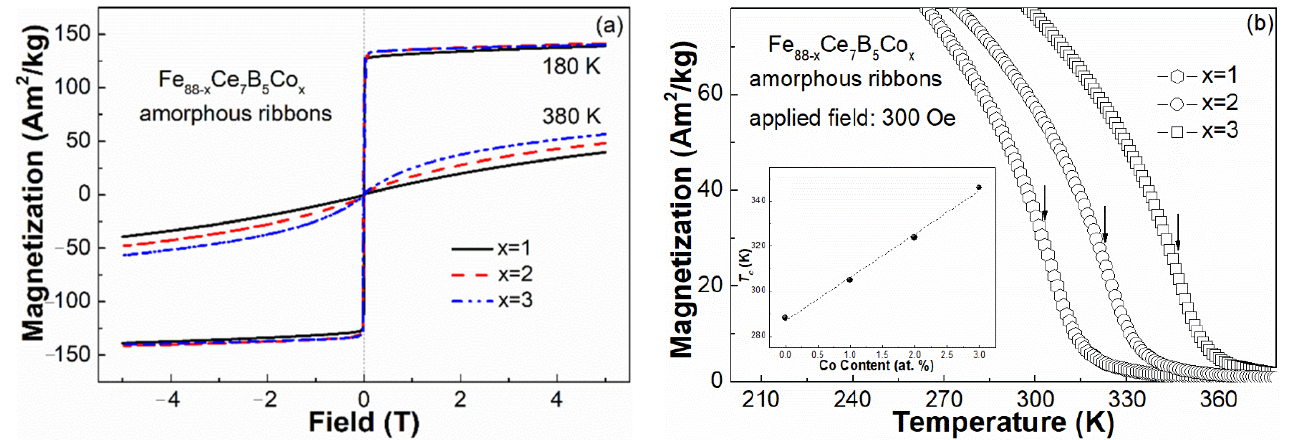
Figure 2. ( a ) The hysteresis loops of the Fe 88- x Ce 7 B 5 Co x ( x = 1, 2, 3) amorphous ribbons measured at 180 and 380 K under 5 T. ( b ) M - T curves of these amorphous ribbons under 300 Oe; the inset is the relationship between T c and Co content.